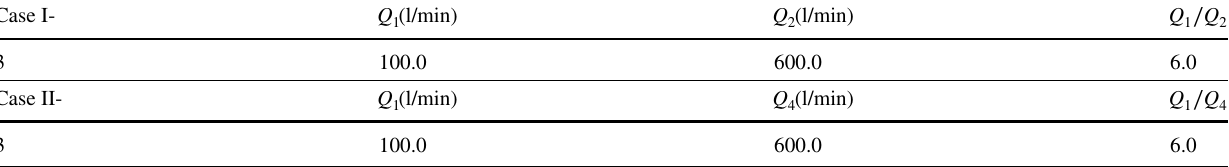
Table 5 Inflow conditions for Cases I-3 and II-3 (①, ② and ④: channel